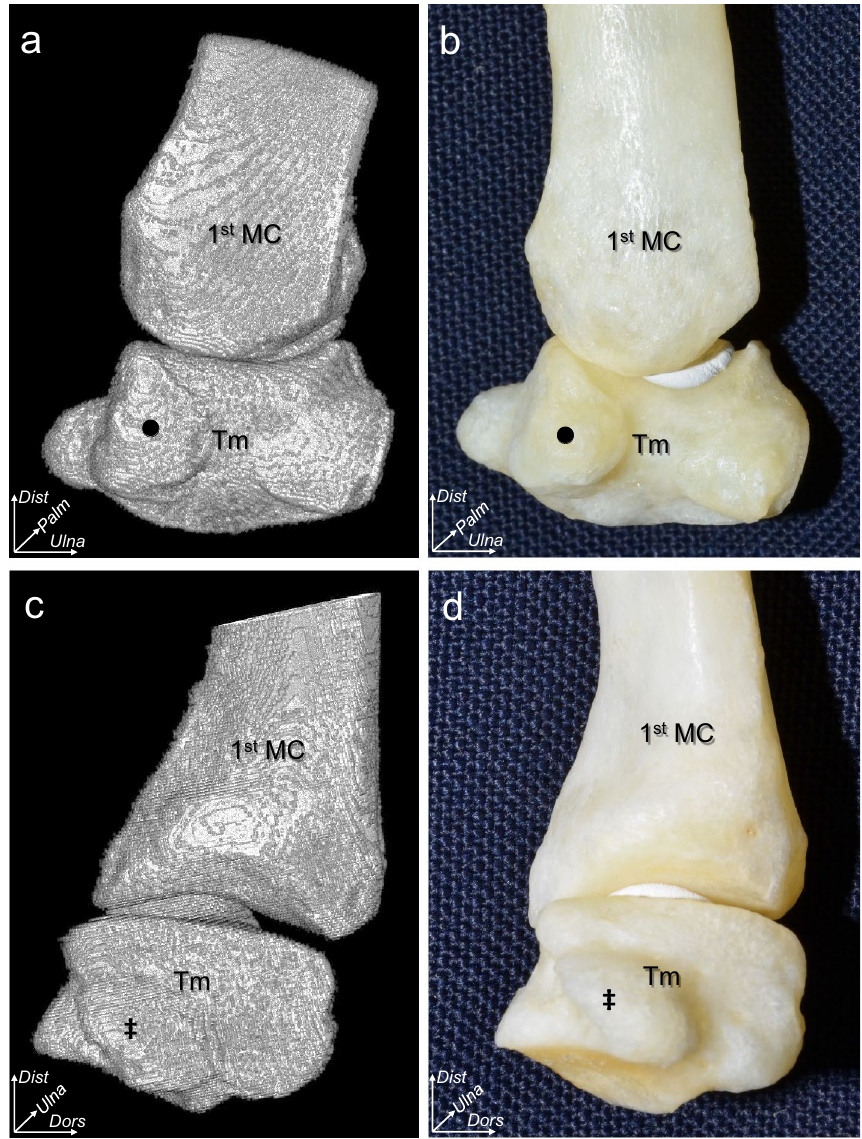
Figure 1. Bone morphology of the trapeziometacarpal joint. Three-dimensional (3D) computed tomography images and actual bone images of the dorsal ( a and b ) and radial aspects ( c and d ) of the trapezium (Tm) and the first metacarpal bones of the right thumb. ( a ) the Tm is prominent (black circle) on the radial side of the dorsal aspect. ( b ) the actual bone images of ( a ). ( c , d ) 3D images and actual bone images of the radial aspect of the trapeziometacarpal joint, respectively. The double-dagger shows the radial roof of the flexor carpi radialis tendon groove. Dist , distal; Ulna , ulnar; Dors , dorsal; Palm ,